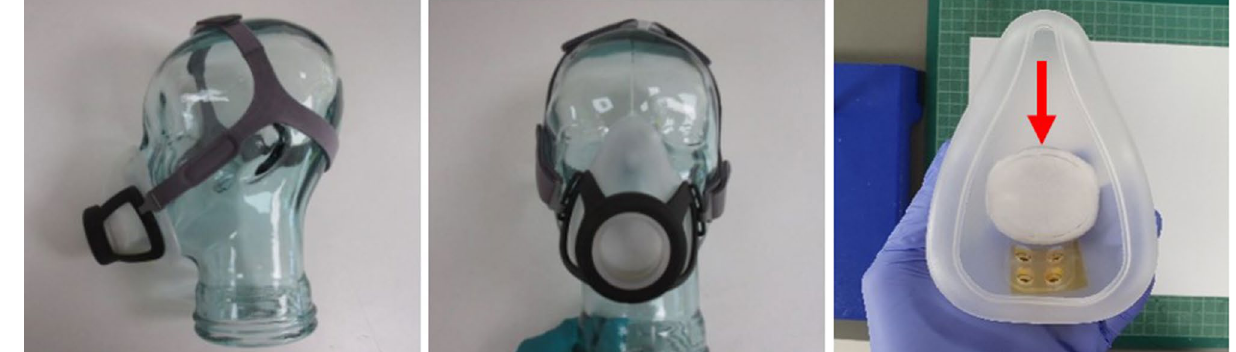
Figure 5. A filter held by a CPAP-type face mask was used to capture exhaled virus particles. The face mask, holder and head strap shown on a glass head in profile (left) and face on (center). An inside view of the face mask (right) with electrostatic filter (red arrow); holes at the bottom were sealed with